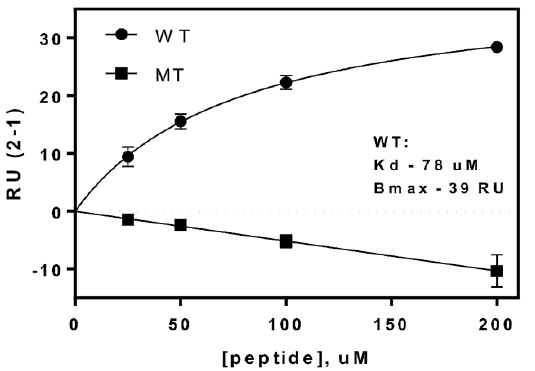
Figure 3. Surface plasmon resonance. Graphical evaluation of eVP40-WT and PPxY mutant peptides binding to GST/WW domain #3 of SMURF2 with response units (RU) plotted on the Y -axis and peptide concentration in uM plotted on the X -axis. The Kd for the WT peptide was calculated to be 78 uM with a Bmax of 39 RU.